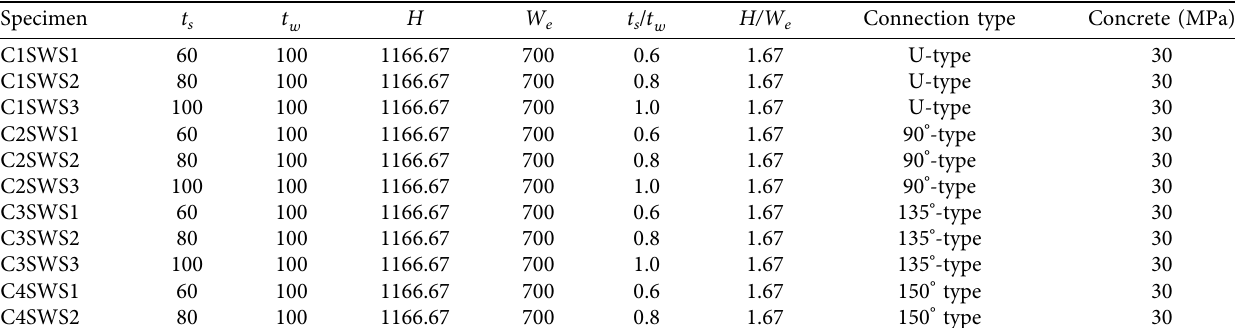
Table 2: Number of specimens used in FE modeling based on the study